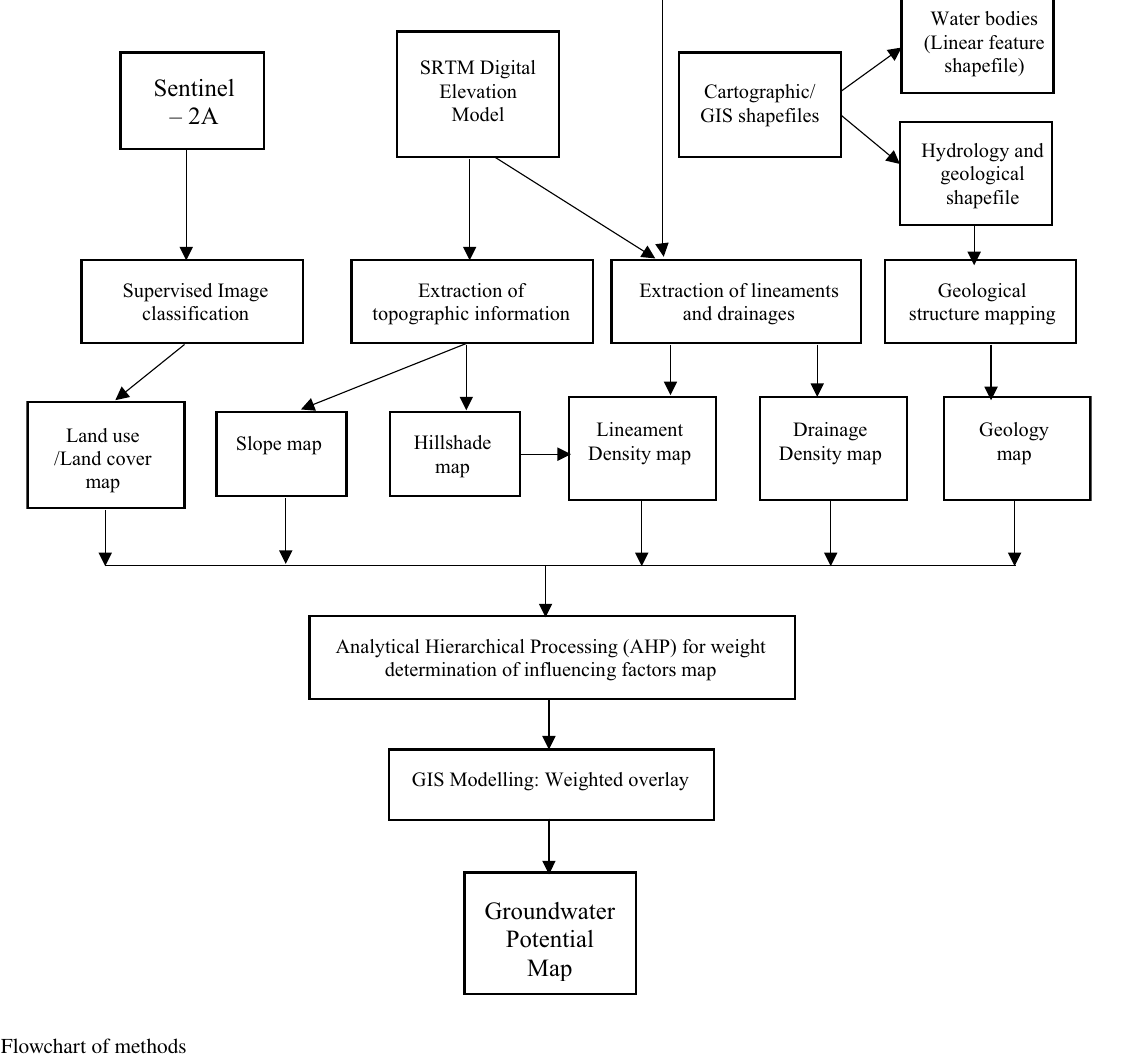
Fig. 2 Flowchart of